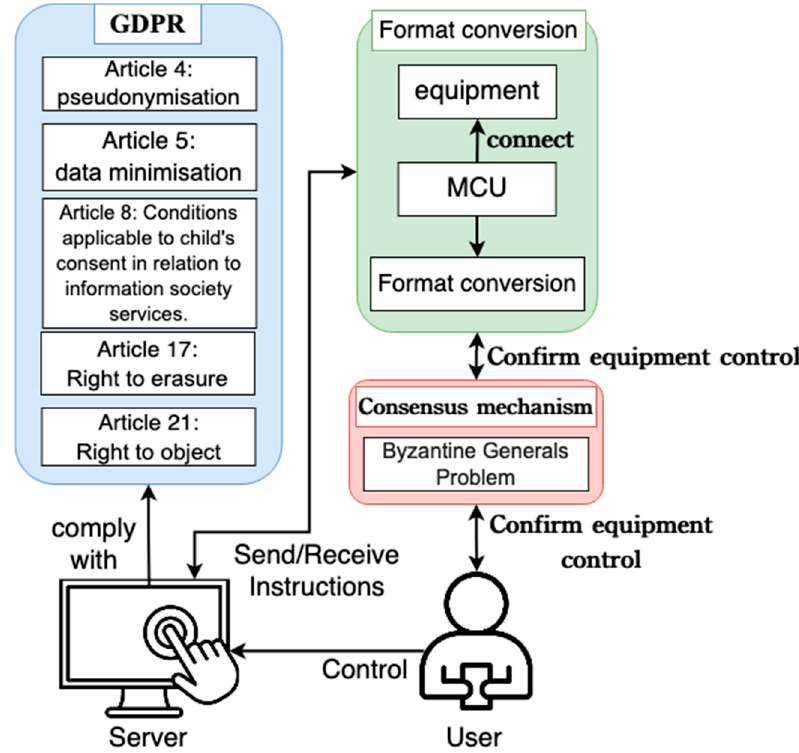
Figure 1. Schematic diagram of system architecture.